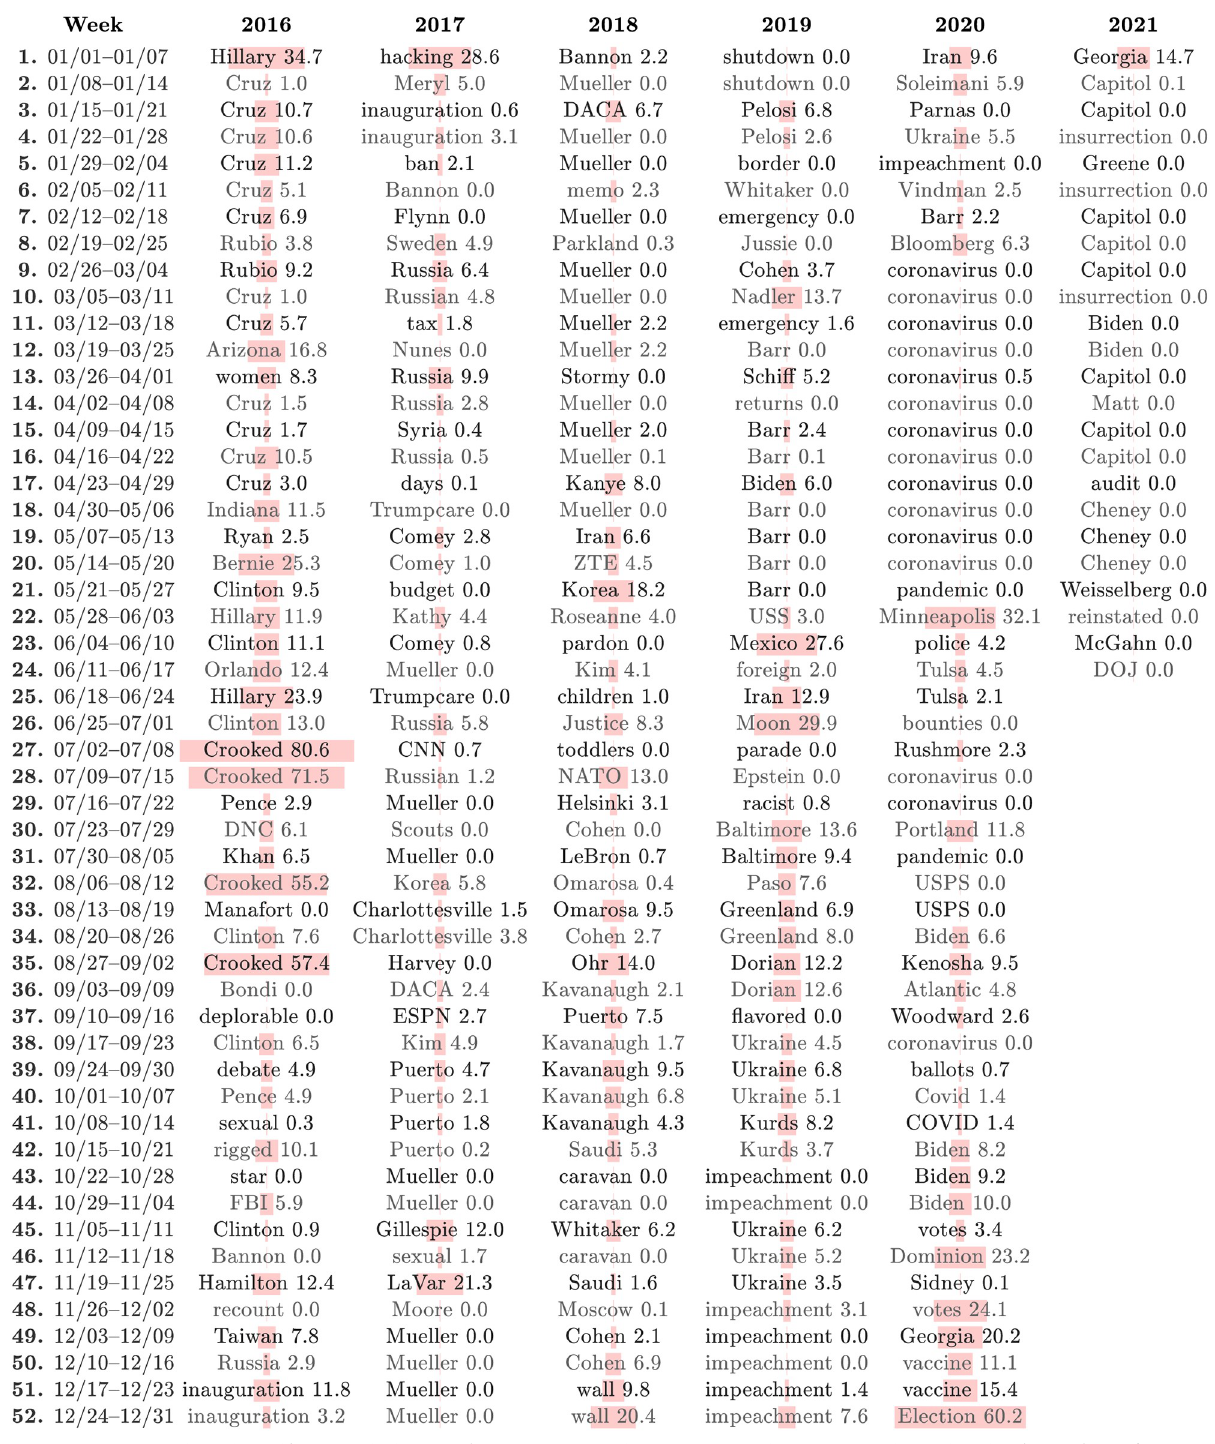
PLOS ONE | https://doi.org/10.1371/journal.pone.0260592 December8, 2021 5 /